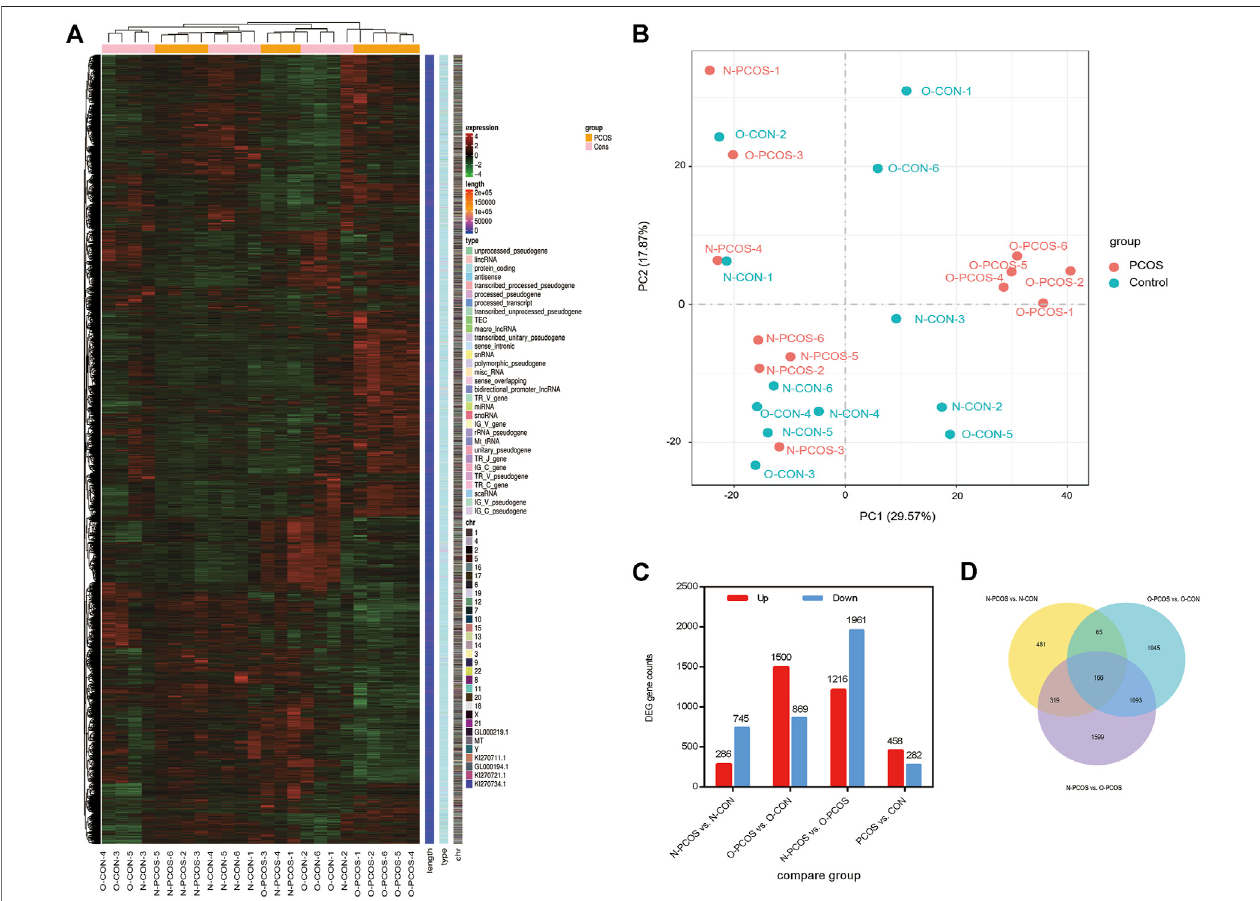
FIGURE 1 | Changes in gene expression pro fi les of the endometrium between PCOS and controls. (A) Unsupervised hierarchical clustering of all gene expression in 24 subjects, six normoweight PCOS (N-PCOS), six overweight/obese PCOS (O-PCOS), six normoweight controls (N-CON), and six overweight/obese controls (O-CON). (B) PCA plot ofRNA-Seq transcriptomesinthe endometriumbetweenPCOS and controls. (C) Numbers ofDEGs inpairwise comparisons. (D) Venn diagram showing the number of DEGs in each comparison, and the overlaps between the three main comparison